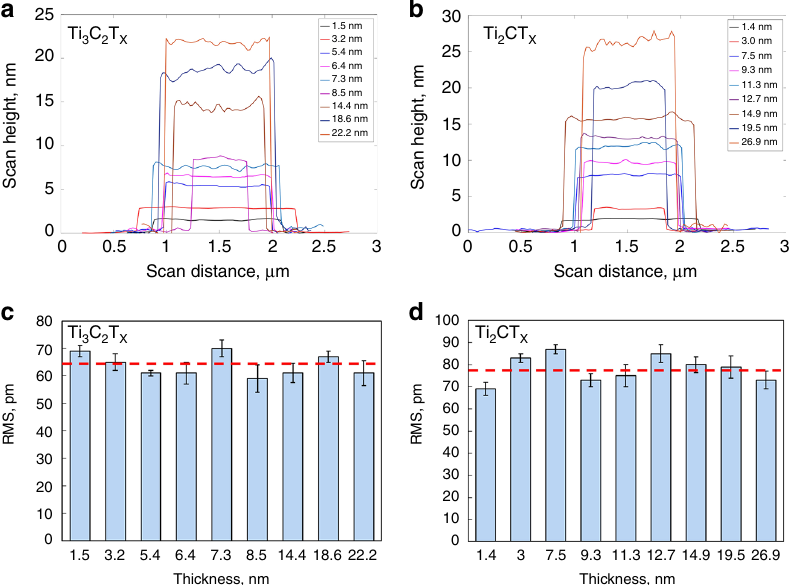
Fig. 2 AFM line scans ( a , b ) and corresponding RMS values ( c , d ) for Ti 3 C 2 T x and Ti 2 CT x fi lms of different thicknesses. Horizontal dash lines in bottom panels represent the average RMS for Ti 3 C 2 T x and Ti 2 CT x , which were used in adhesion energy calculations. Error bars represent standard deviations